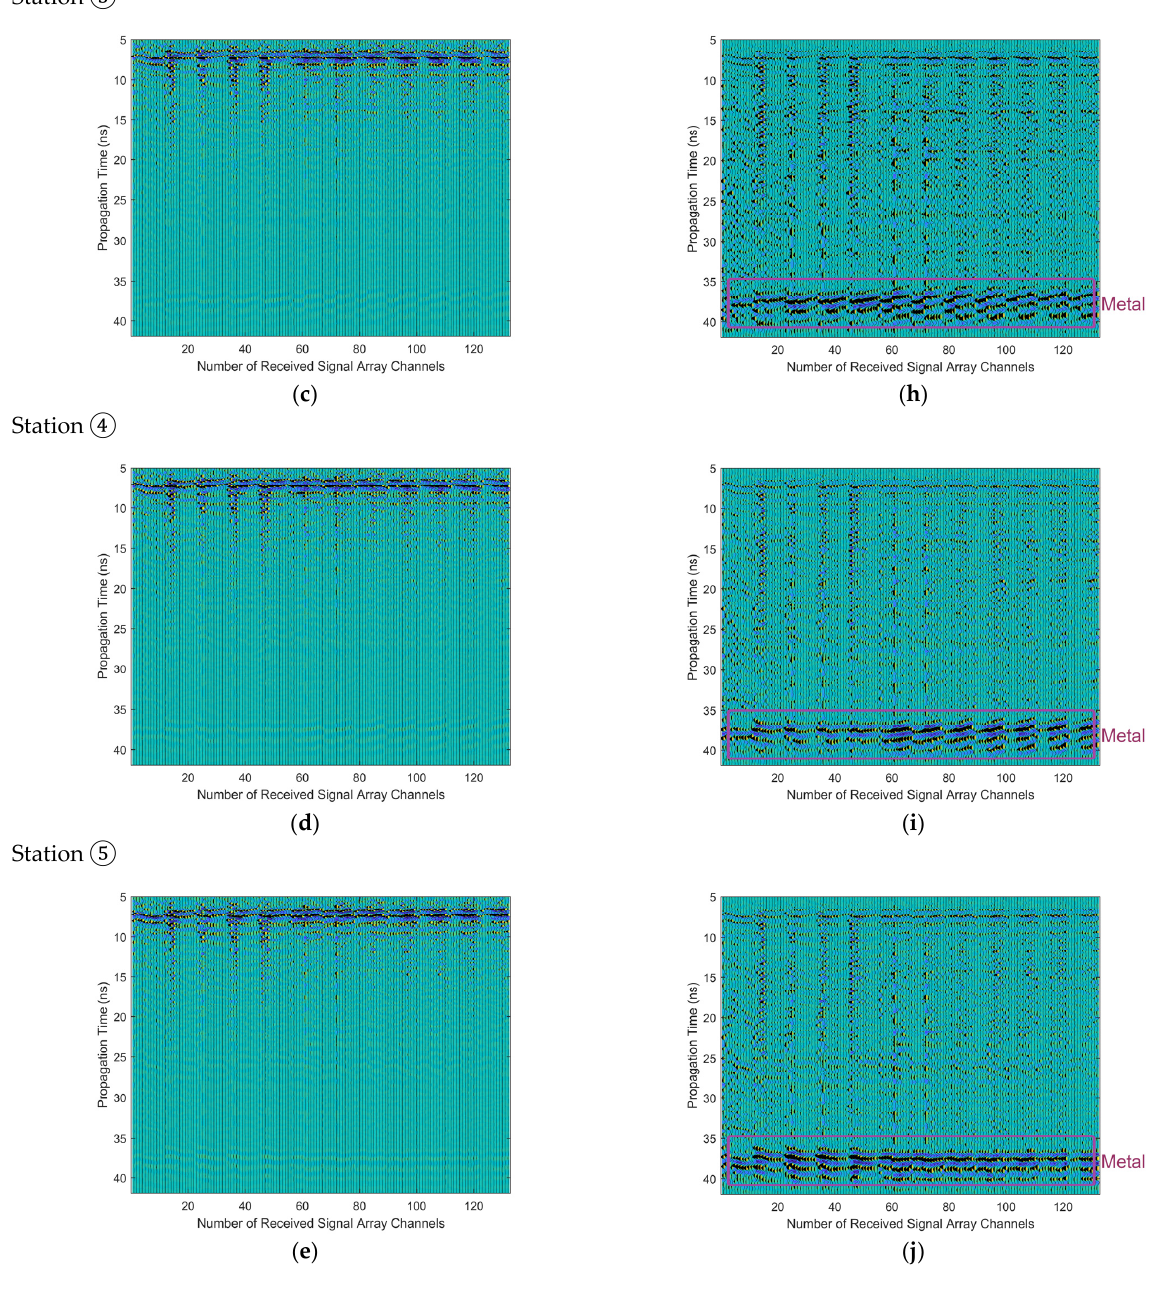
Figure 6. 132 channels’ echoes for the CE-5 experiments in the five stations: ( a – e ) for initial echoes and ( f – j ) for optimal echoes.